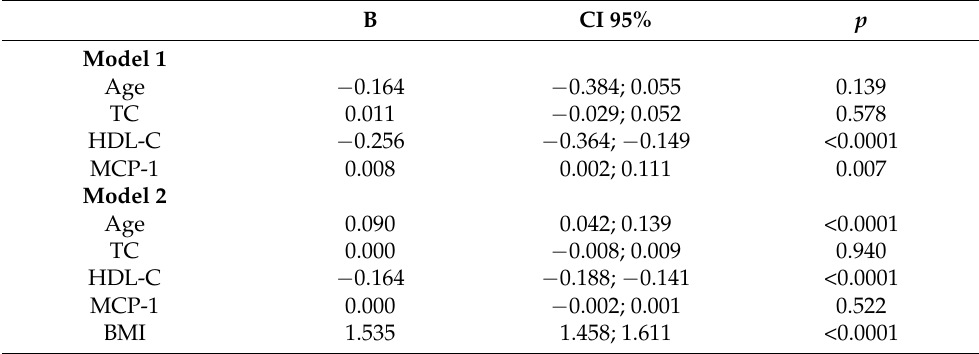
Table 6. Linear regression analyses exploring the association of MCP-1 (Monocyte Chemoattractant Protein-1) with METS-IR, controlling for multiple confounding factors in women ( n = 82). B CI